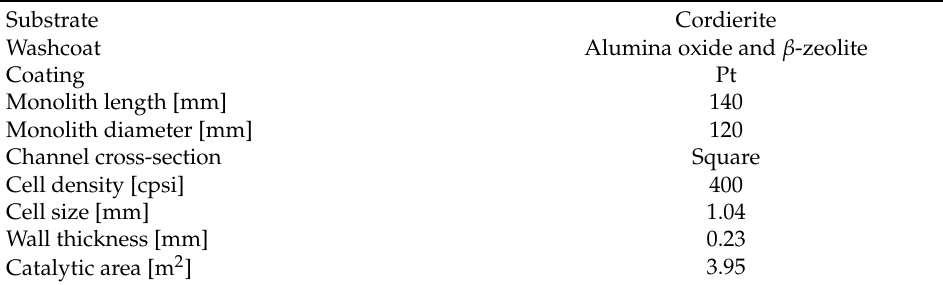
Table 3. Main characteristics of the oxidation